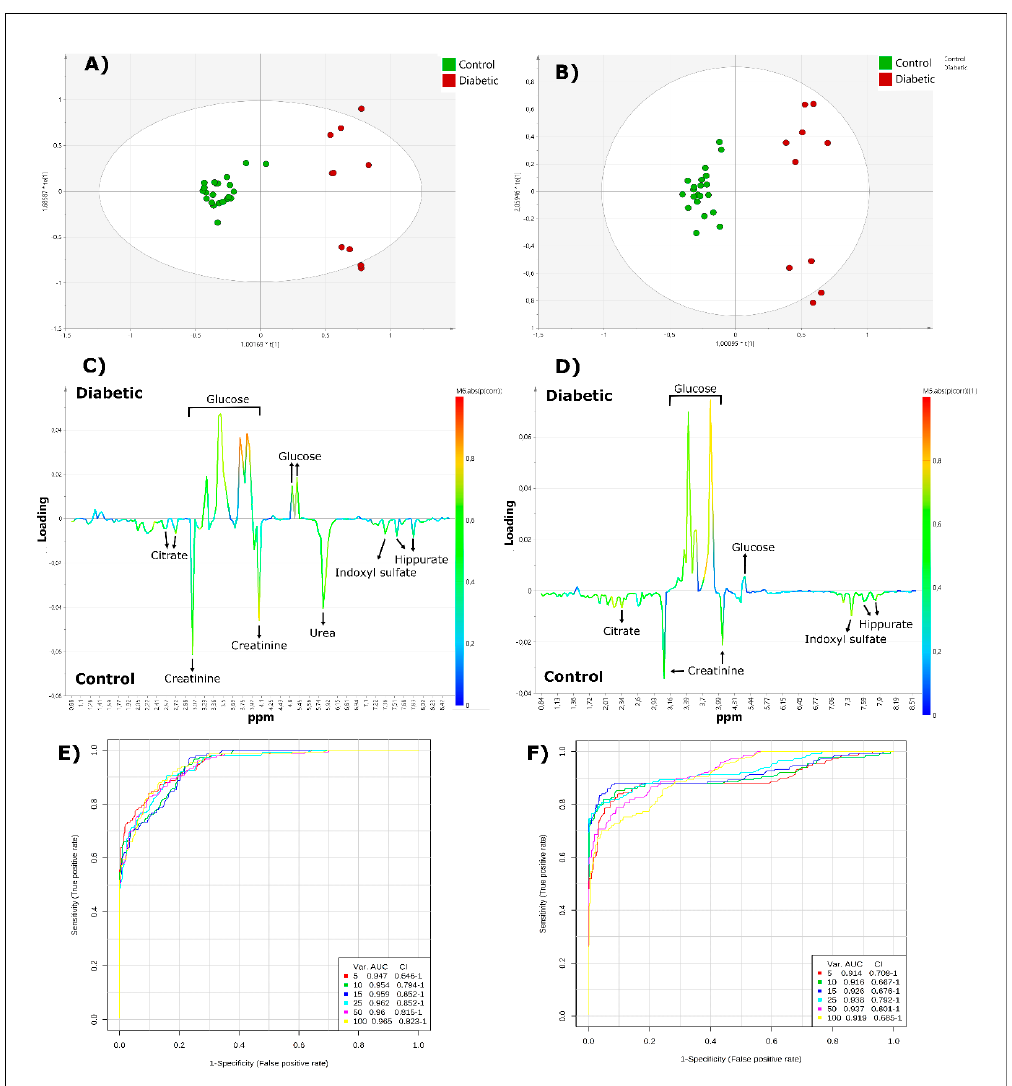
Figure 2. Metabolomics analysis of T2D 1 H NMR urinary profiles ( n = 10), versus those of healthy controls ( n = 15), acquired using HF and LF NMR spectrometers. Scores plots ( A , B ), and corresponding loading-plots ( C , D ) from orthogonal partial-least squares discriminant analysis (OPLS-DA) applied to 1 H-NMR spectra of control versus T2D samples, acquired using HF ( A , C ) or LF ( B , D ) 1 H NMR